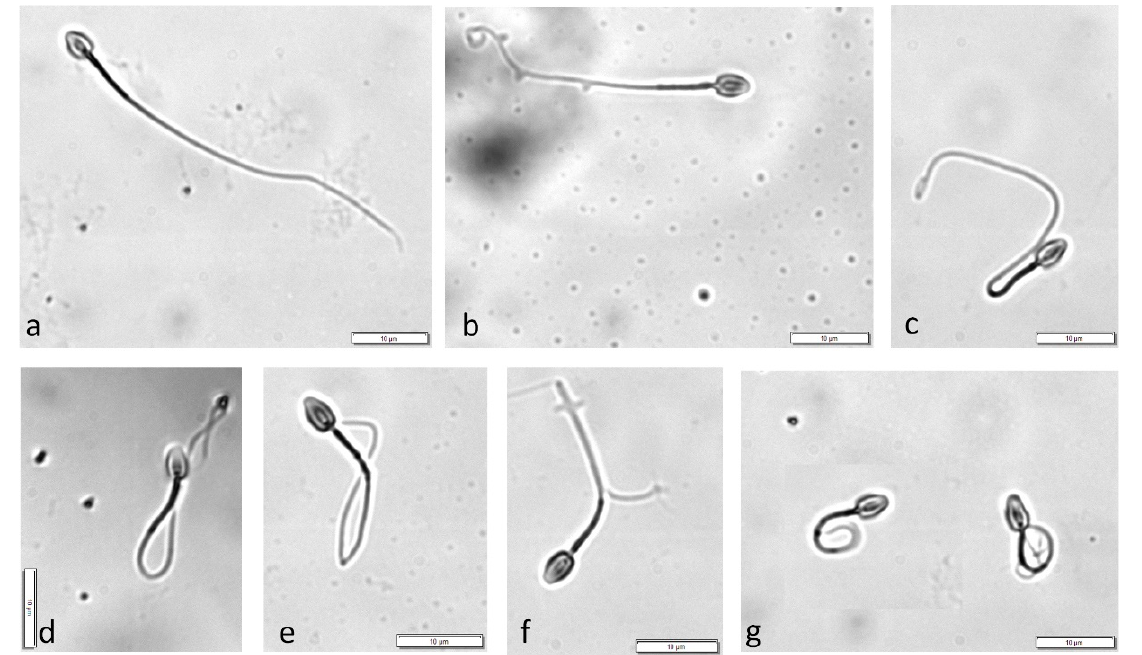
Figure 1. Different morphological changes observed in cat spermatozoa exposed to hypo-osmotic solutions—representative pictures. Coiling patterns classification according to WHO manual [1]. ( a ) spermatozoon HOST negative (tail not coiled). ( b – g ) spermatozoa classified as HOST positive (in-